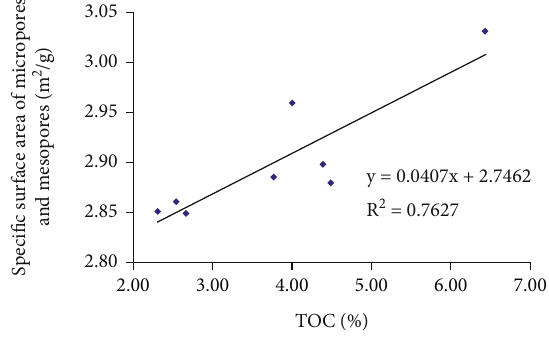
Figure 9: The relationship between the TOC and the speci fi c surface area of micropores and